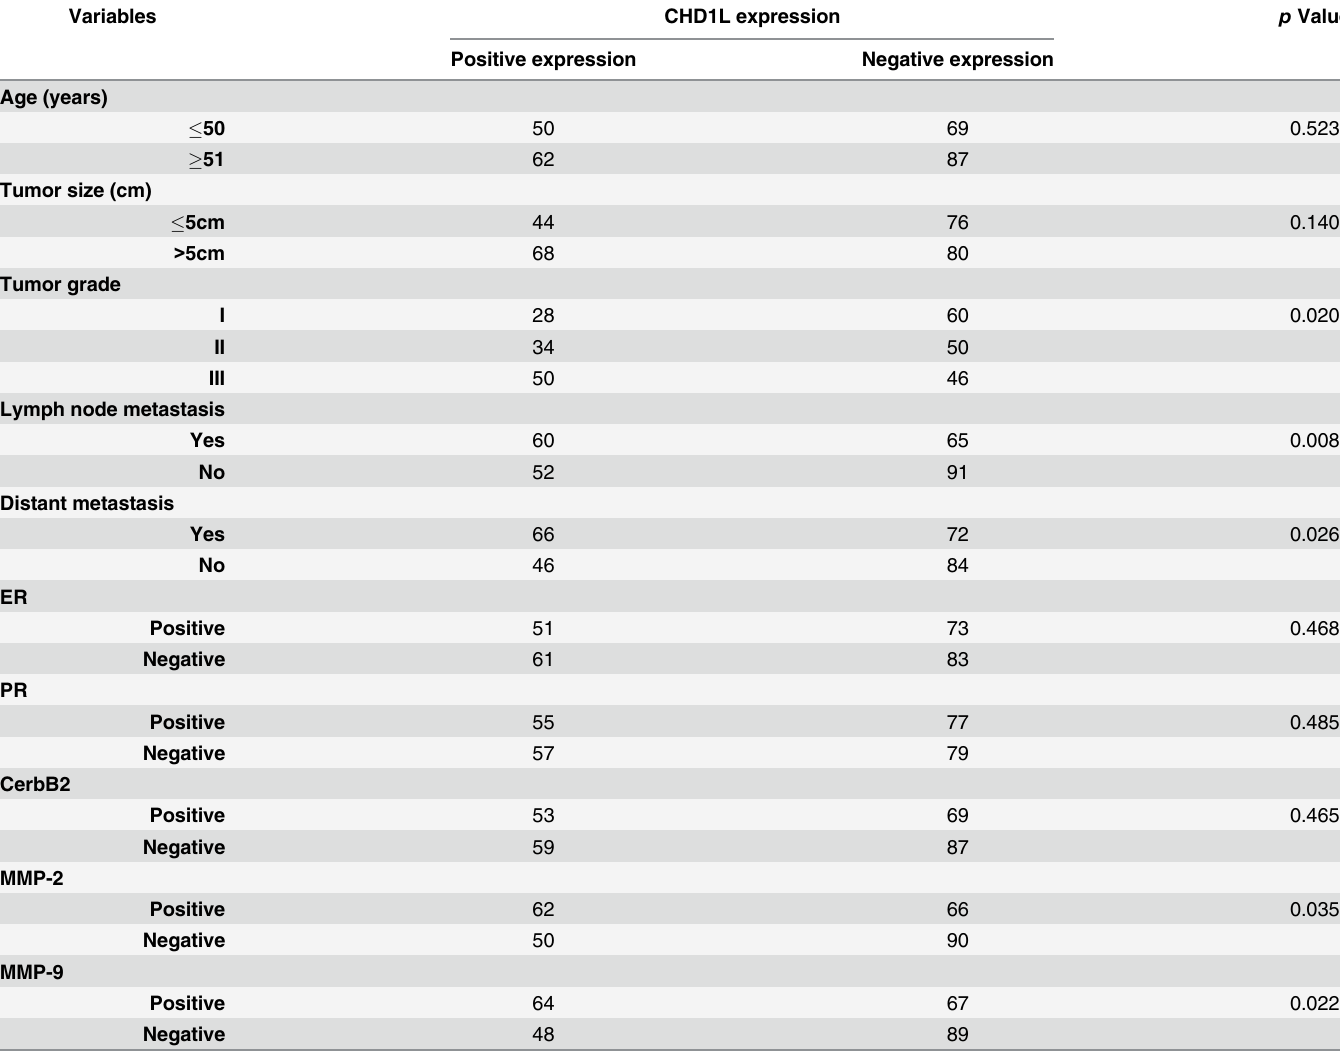
Table 1. Association between CHD1L expression and clinical features of invasive ductal carcinoma patients. Variables CHD1L expression p Value Positive expression Negative